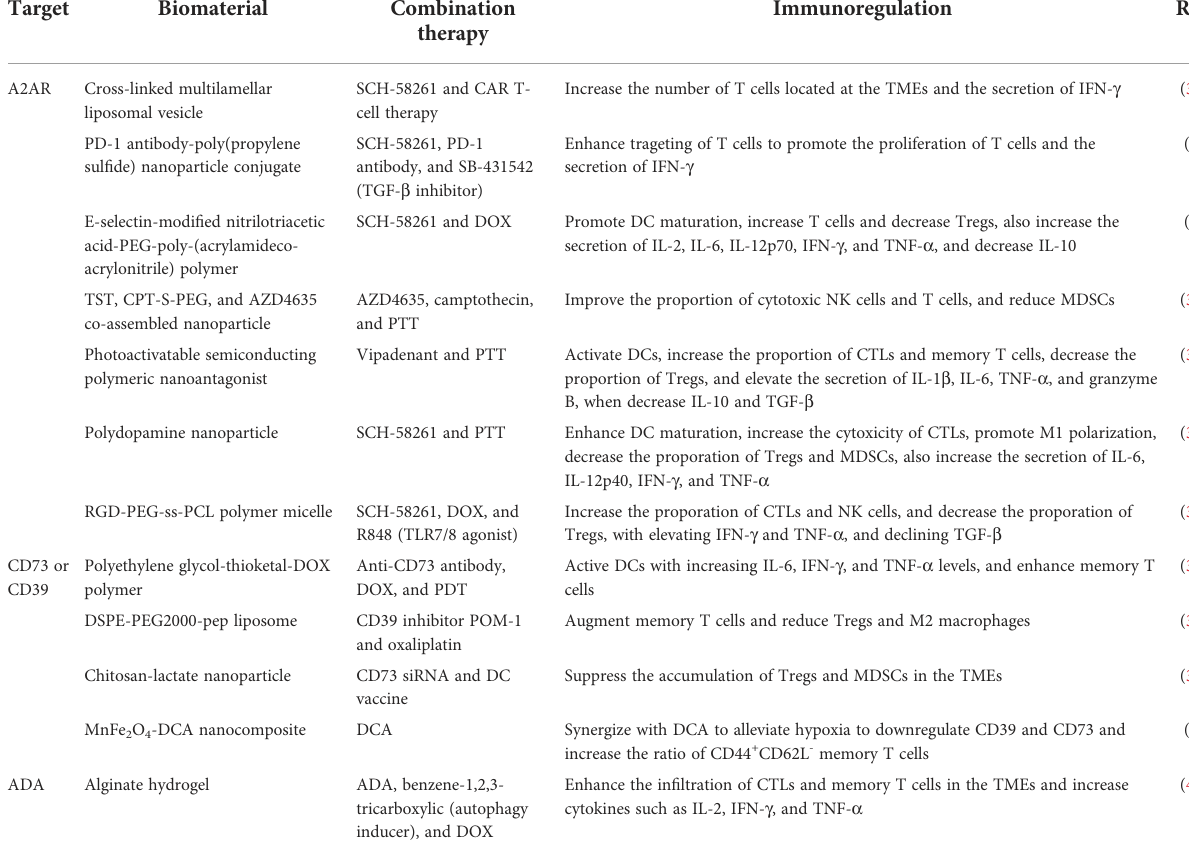
TABLE 1 Biomaterial-based strategies to regulate the adenosine signaling pathways for cancer immunotherapy.